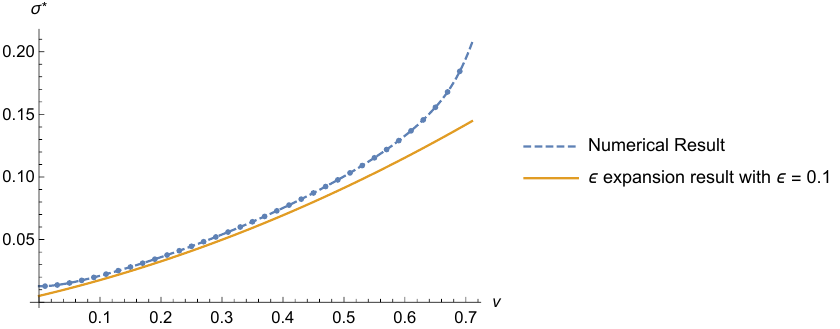
Figure 6. Saddle point value of σ ∗ in d = 3 . 9 critical theory with ∆ − boundary condition and for comparison, the analytic result in d = 4 − (cid:15) at (cid:15) = 0 . 1